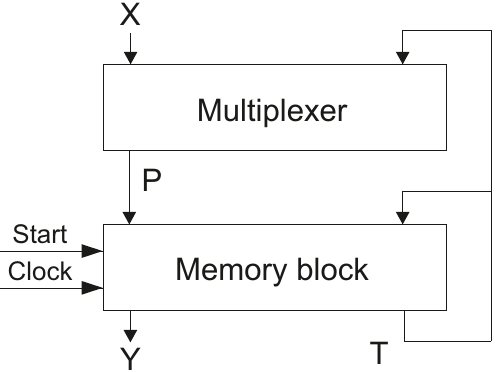
Figure 2. Structural diagram of FSM U 2